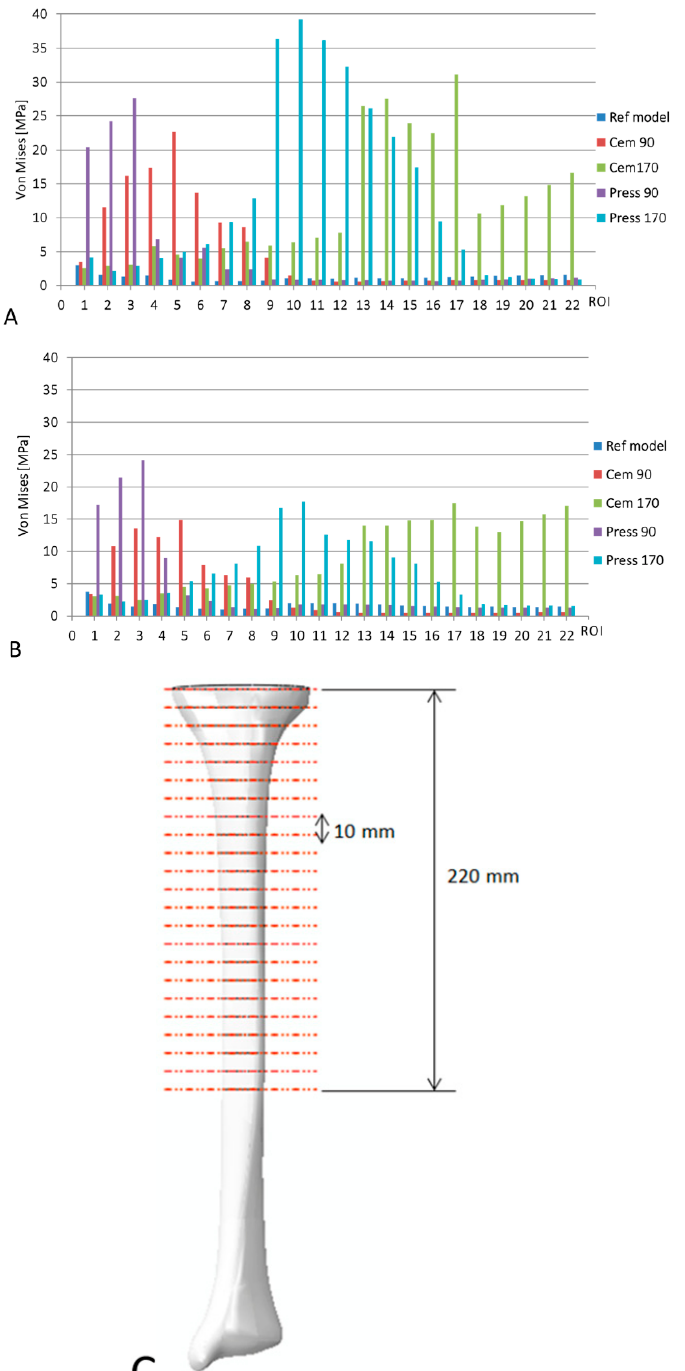
Figure 7. Average von Mises stress estimated in the medial ( A ) and lateral ( B ) side for the different regions of interest ( C ) in the case of the tibial stem. The results of the reference model are also reported in the figure.